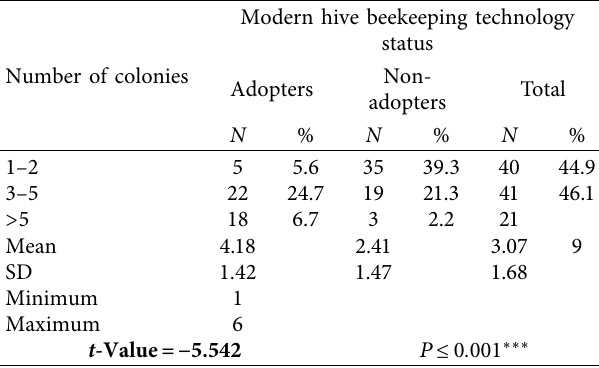
Table 9: Distribution of respondents by number of